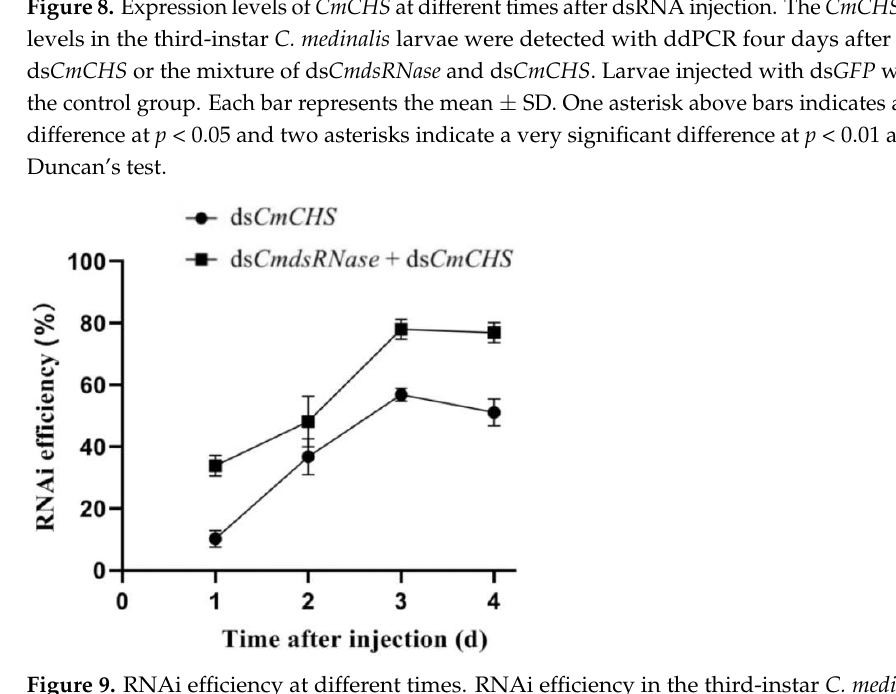
Figure 9. RNAi efficiency at different times. RNAi efficiency in the third-instar C. medinalis larvae was calculated four days after injection of ds CmCHS or the mixture of ds CmdsRNase and ds CmCHS. Data are shown as the means ± SD.